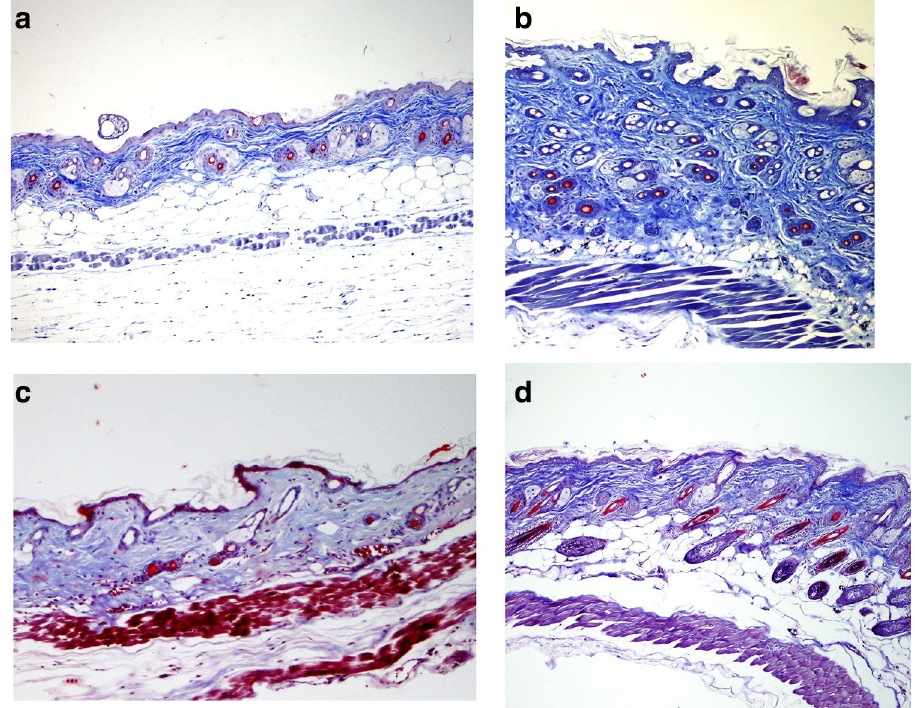
Figure 2. Dermal fibrosis in the study groups (Masson’s Trichrom staining, ×100). Normal histopathological view of mice immunized with PBS in control group ( a ). Increased dermal thickness, infiltration of inflammatory cell, fibrosis in the BLM-injected sham group ( b ). Tofacitinib ( c ) and metformin ( d ) applications decreased the dermal thickness, infiltrations of inflammatory cells, and fibrosis in the BLM injected mice.